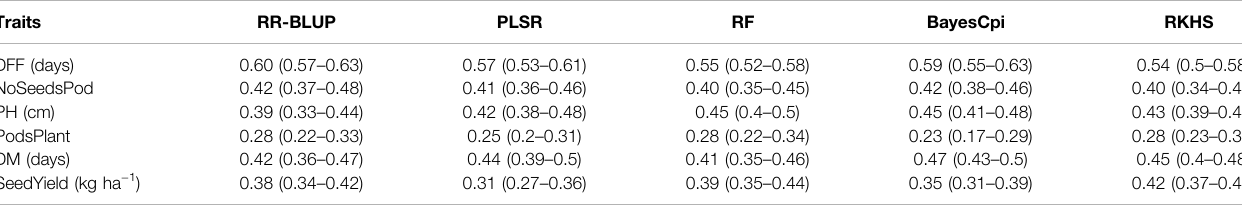
TABLE 2 | Predictive ability for seed yield and agronomic traits using fi ve genomic prediction models. Traits